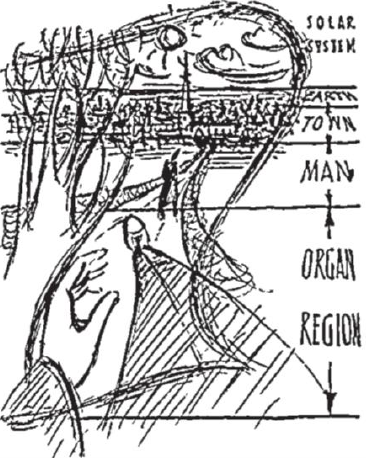
Figure 5. My view out including the levels of my greater body [8] (p. 10). Reproduced with permis- sion of the Shollond Trust. permission of the Shollond